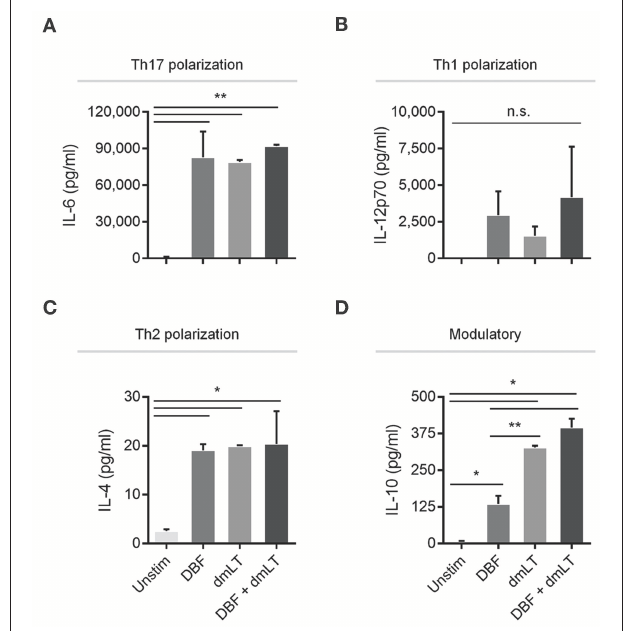
FIGURE 4 | Cytokine secretion by DC after various treatments. DC populations exposed to PBS, DBF, dmLT, and the combination DBF + dmLT show different patterns of cytokine secretion and are presented according to their T-cell polarization role. A. IL-6, a cytokine critical for Th17 lineage commitment is enriched in all antigen-treated populations 2h post-treatment. All samples are significantly different than PBS. (B) Th1-polarizing cytokine IL-12p70 is not significantly different across treatments. (C) Th2-polarizing cytokine IL-4 was significantly different in all antigen-treated samples vs. PBS. (D) IL-10 had an incremental secretion pattern, with all antigen-treated samples significantly different than the PBS control, and significant differences between DBF and dmLT or DBF + dmLT. Each bar represents the mean and SD of duplicate biological samples. Statistical significance was analyzed with an ordinary one-way ANOVA with a Tukey post-hoc test. All comparisons tested with an α value of 0.05. * p < 0.05, ** p <